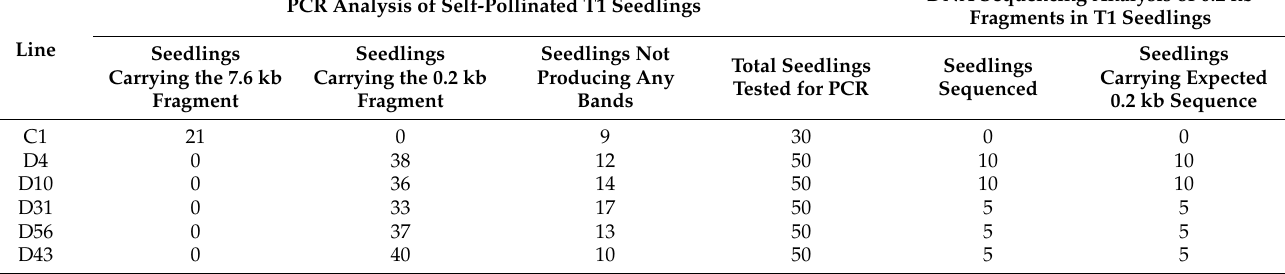
Table 4. PCR verification of transgene excision efficiency in the T1 seedlings that were produced by self-pollinating transgenic plants in the field. Line C1 (control line) was transformed with the control cassette; lines D4, D10, D31, D56, and D43 were transformed with the ‘pollen- and seed-specific Gene Deletor’